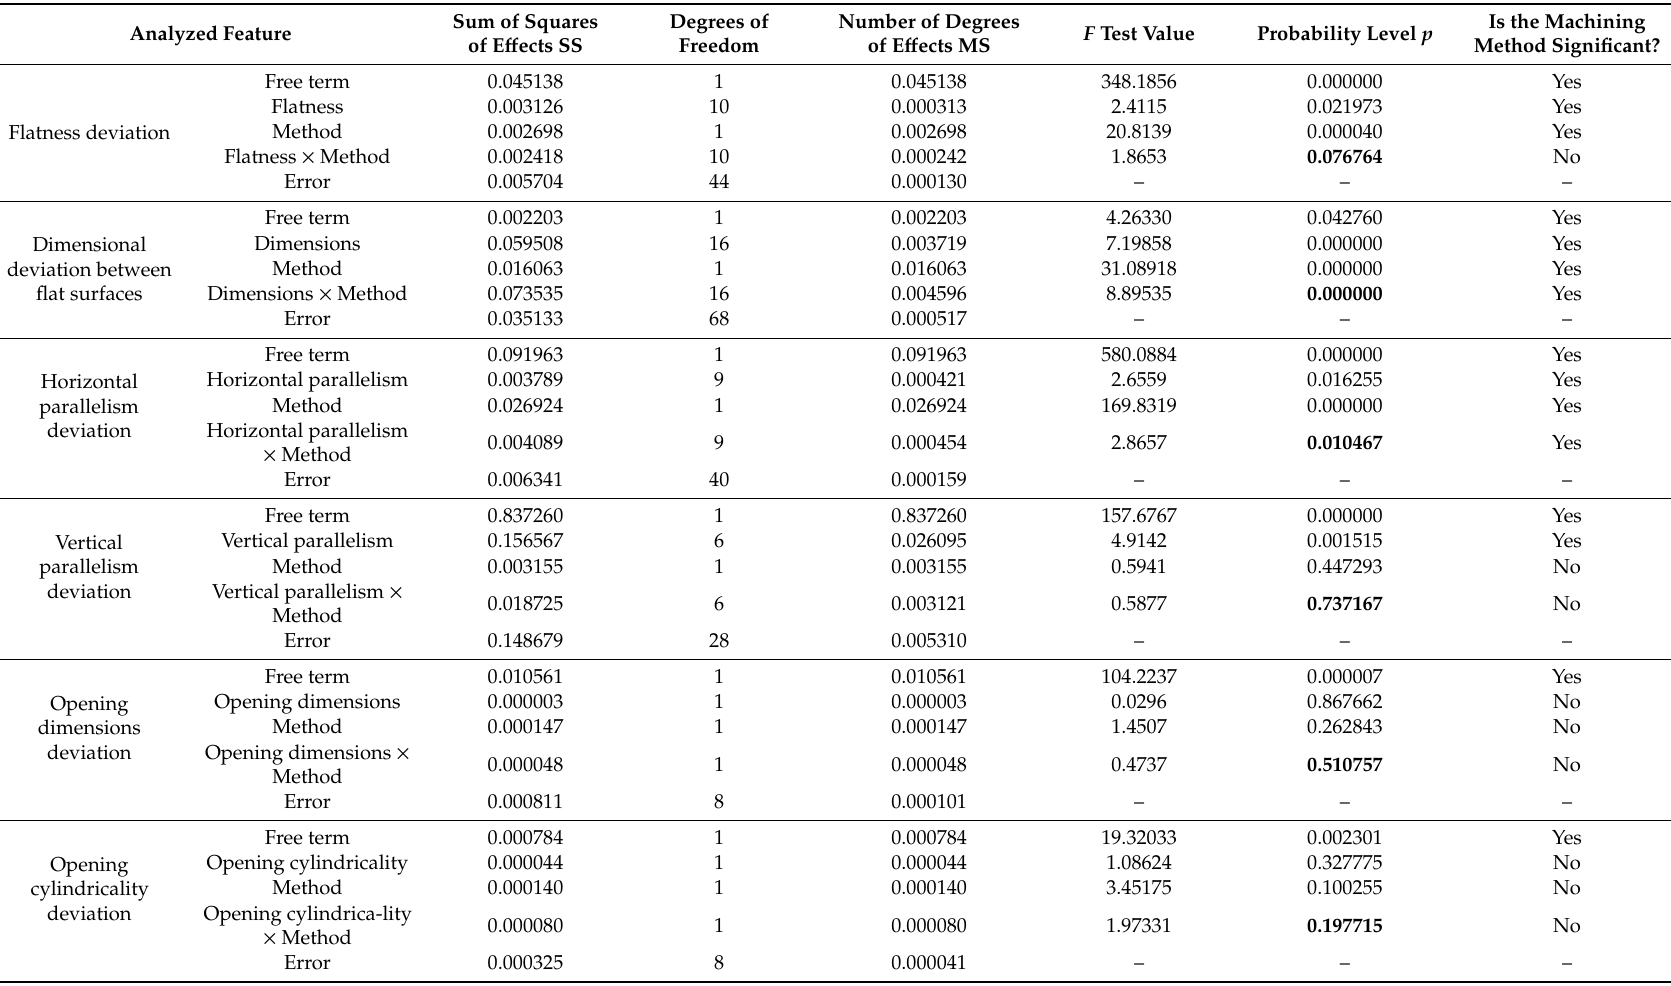
Table 4. Results of the analysis of variance by the Analysis of Variance (ANOVA) method of the obtained geometrical measurements (in the table, the probability values for the features under consideration are